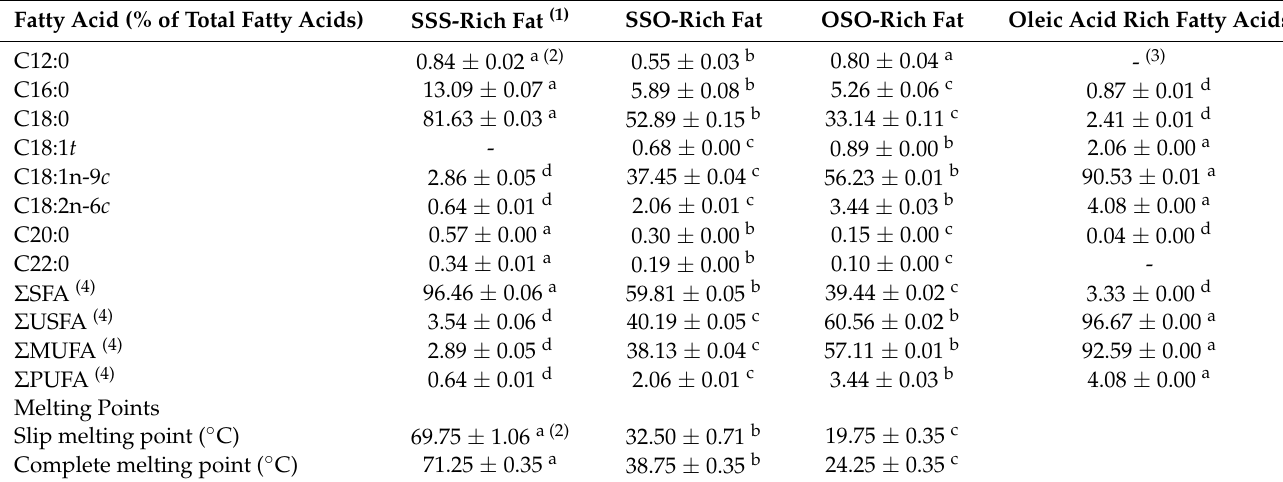
Table 1. The total fatty acids composition of the